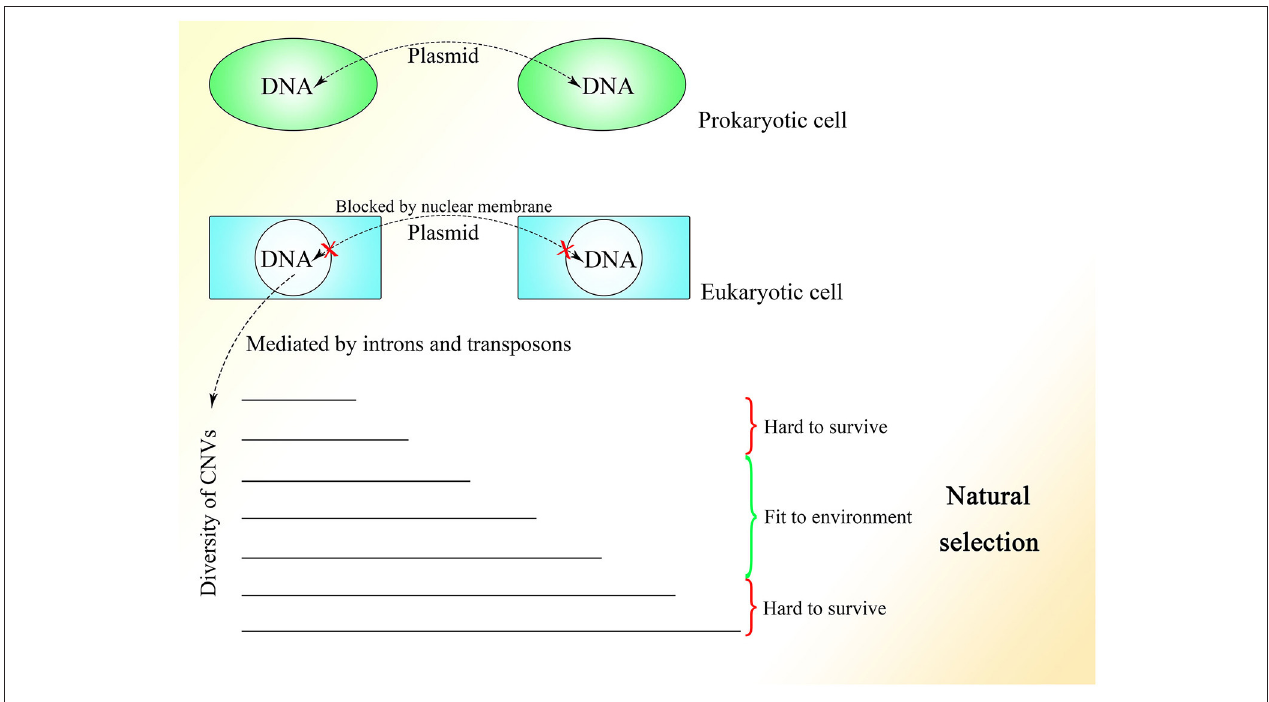
FIGURE 5 | The CNV extension mechanism in evolution. The nuclear membrane of eukaryotes reduces interference from outside the nucleus, creating the environment required for stable and precise CNV extension under control while introns provide various CNVs with different lengths under regulation. The CNVs of different individuals in the same group could be oscillatory, and natural selection would pick out those individuals with CNVs fit to the